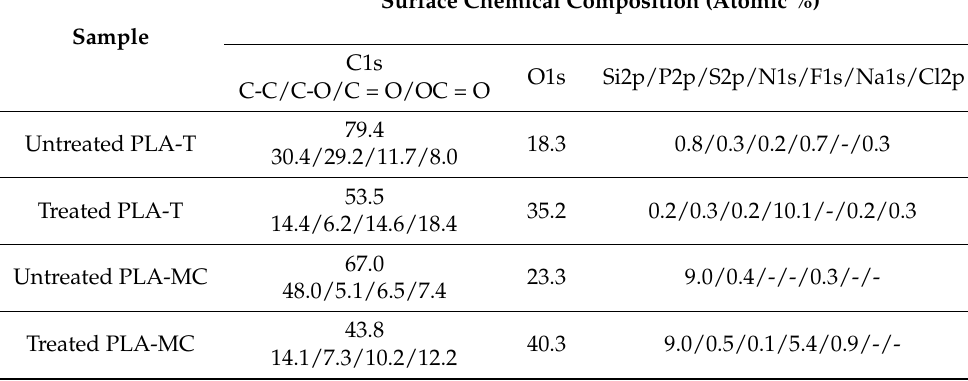
Table 1. Surface chemical composition of PLA-T and PLA-MC series, as determined by XPS.